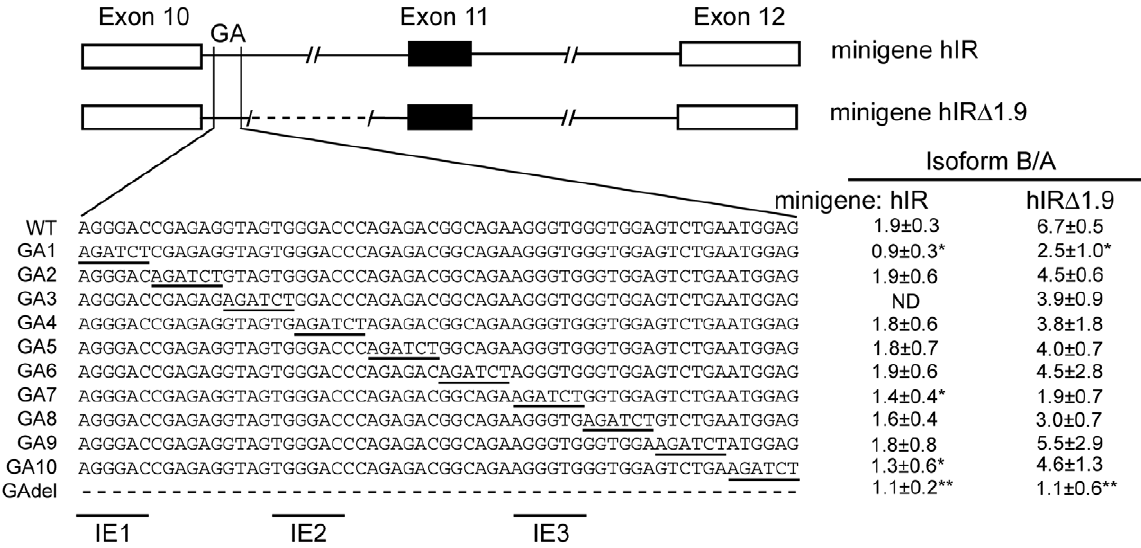
Figure 1. A GA-rich sequence is located near the 5 9 region of intron 10 of INSR . A schematic diagram of minigenes hIR and hIR D 1.9 is shown. White boxes represent exon 10 and 12 and the black box represents exon 11. The intervening lines indicate the introns in between. Dotted lines indicate deletions. Solid perpendicular lines in minigene hIR and hIR D 1.9 demonstrate the boundary of the GA rich sequence. Sequences of GA rich region and the series of linker scanning mutants (GA1-10) are shown below. The ratio of isoform IR-B that includes exon 11 to isoform IR-A that excludes exon 11 ( 6 standard deviation) is given at the right hand site for minigene hIR D 1.9 and hIR as well as the mutants, after transient transfection into HepG2 cells. Asterisks indicate statistical significance (*p # 0.05, ** p # 0.01) vs. wild-type sequence for n=4 experiments. ND represents not determined. IE1, IE2 and IE3 indicate the intron elements used for subsequent in vitro binding experiments.